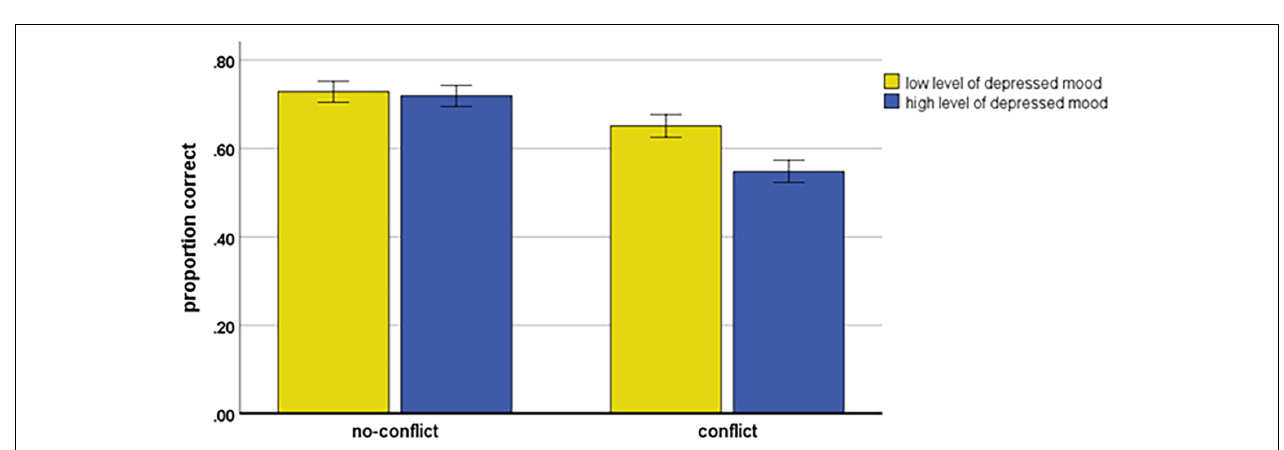
FIGURE 3 | Accuracy of syllogistic reasoning as the function of Depressed mood and Conflict. Error bars represent the standard errors of the mean.